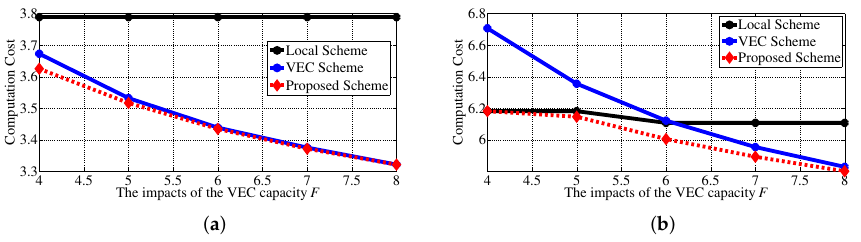
Figure 6. The impacts of the capacity of the VEC server on the computation cost. ( a ) γ i , t = 0.2, γ i , e = 0.8; ( b ) γ i , t = 0.5, γ i , e =